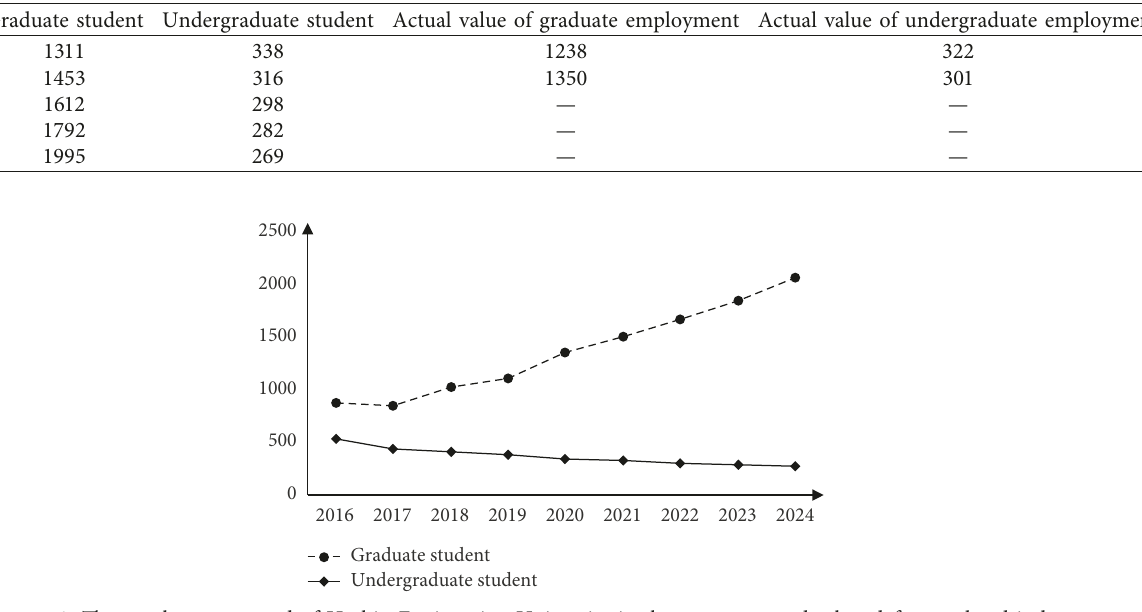
Table 9: The forecasting employment data from Harbin Engineering University in the aerospace and other defense-related